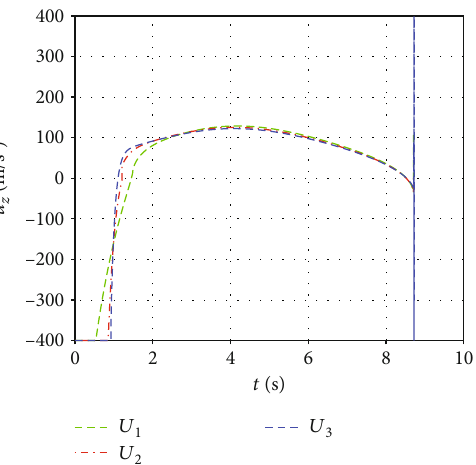
Figure 38: Acceleration instruction u